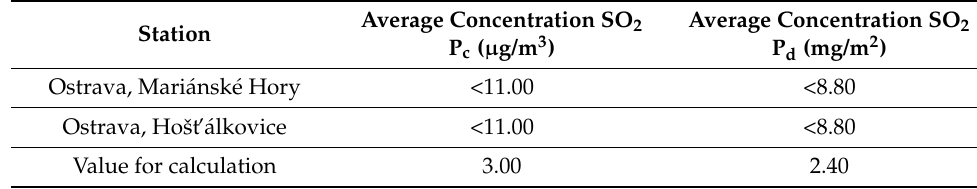
Table 25. Average concentration of SO 2 in 2021 [35] and value for calculation r corr .